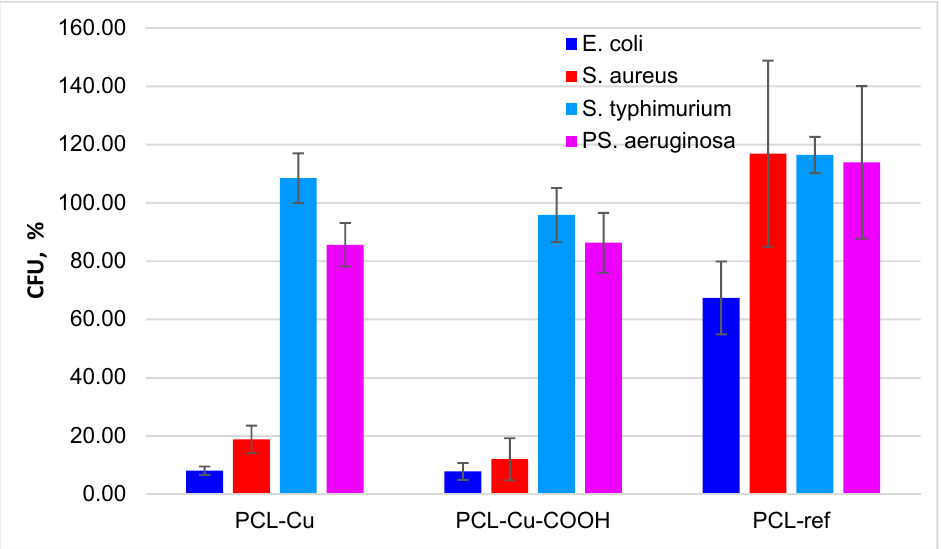
Figure 11. Antimicrobial effects of the PCL ‐ ref, PCL ‐ Cu and PCL ‐ Cu ‐ COOH as the percentage of colony forming units (CFU) relative to the CFU of the control. Table 3. Antibacterial activity. The percentage is of CFU relative to the CFU of the control. The reliability of the differences was calculated according to the Student’s criterion with the degree of freedom number 4 (3 + 3 ‐ 2), ( p < 0.01). Positive control was performed using PCL ‐ COOH with covalent bonded of Penicillin ‐ Streptomycin ‐ Neomycin (PSN) Antibiotic Mixture under the same conditions.